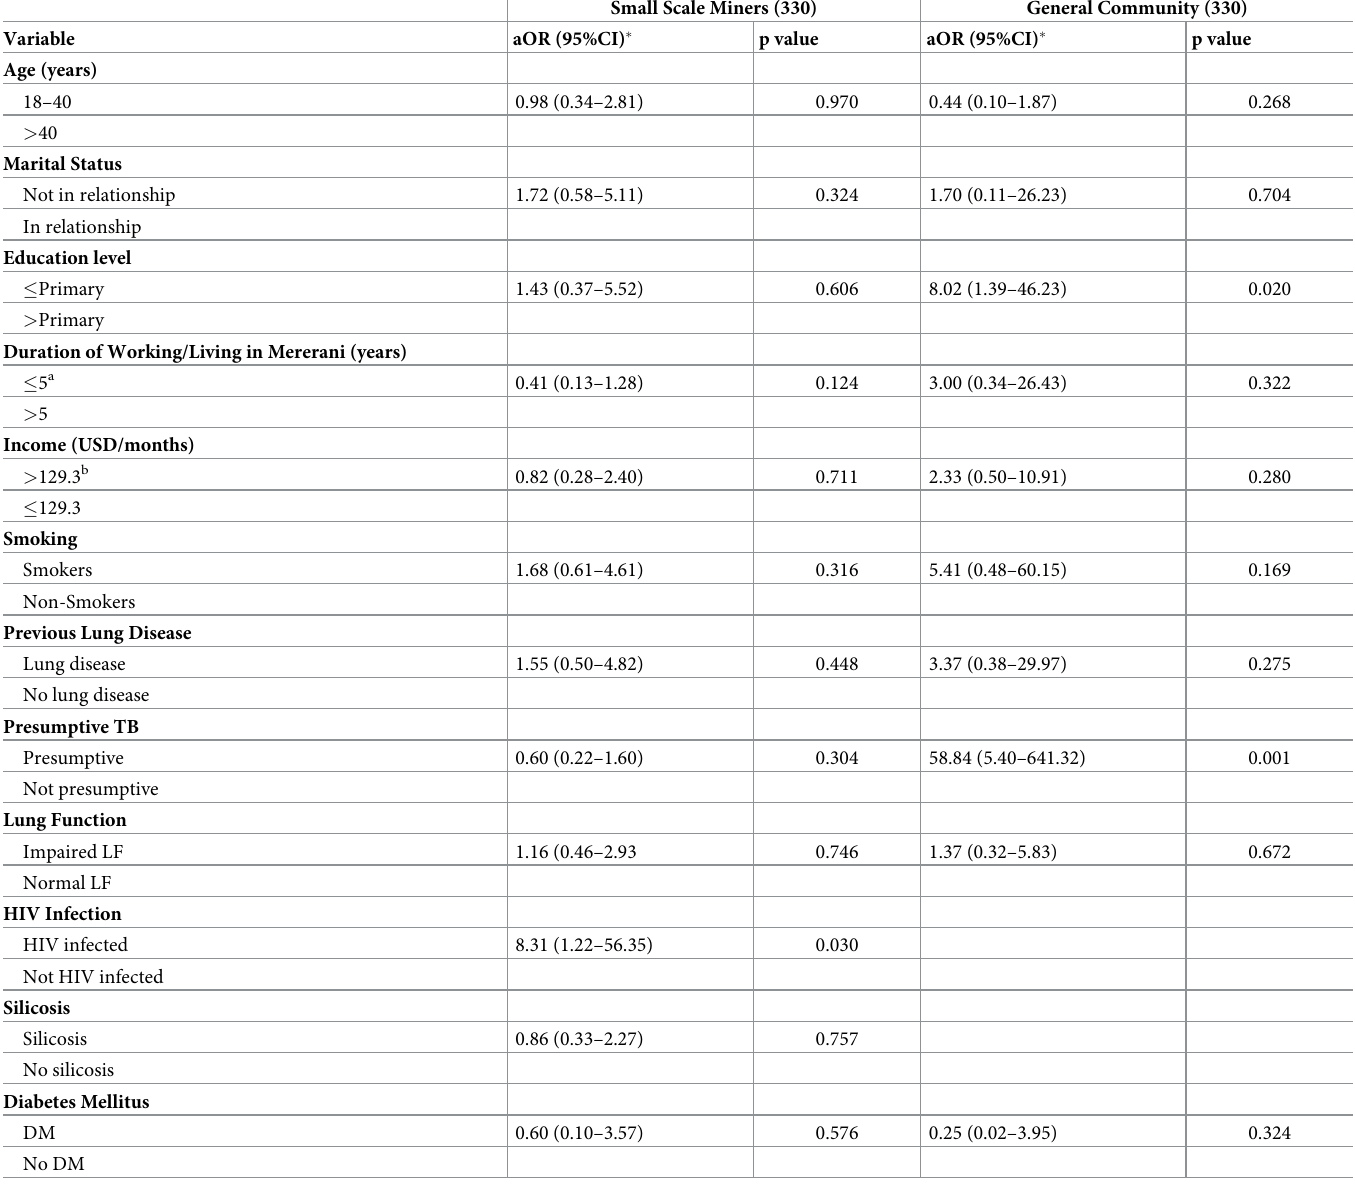
Table 4. Factors associated with tuberculosis among mining communities: Stratified by occupation (N =